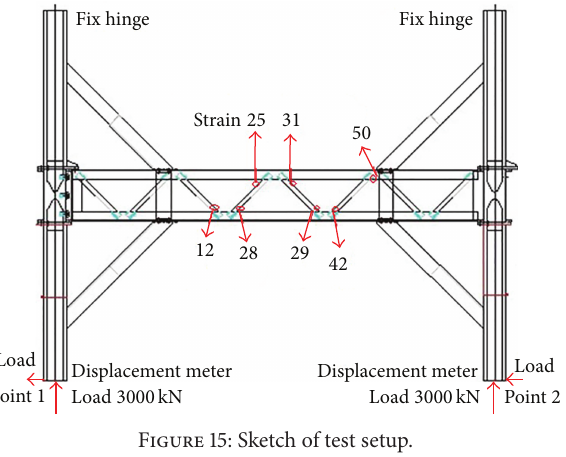
Figure 15: Sketch of test setup.